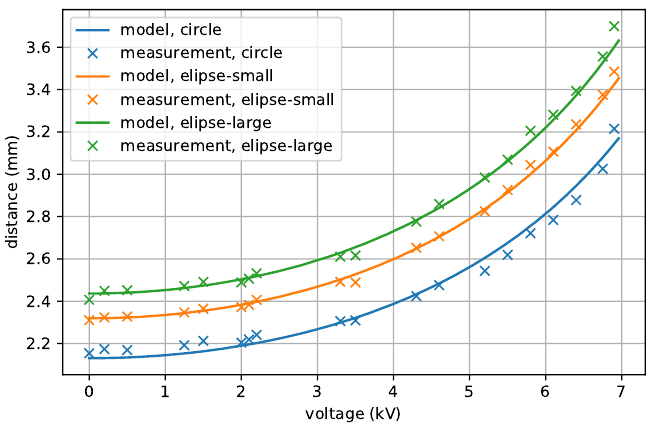
Figure 7. The static response of DEAP actuator for a mass of 17.9g.